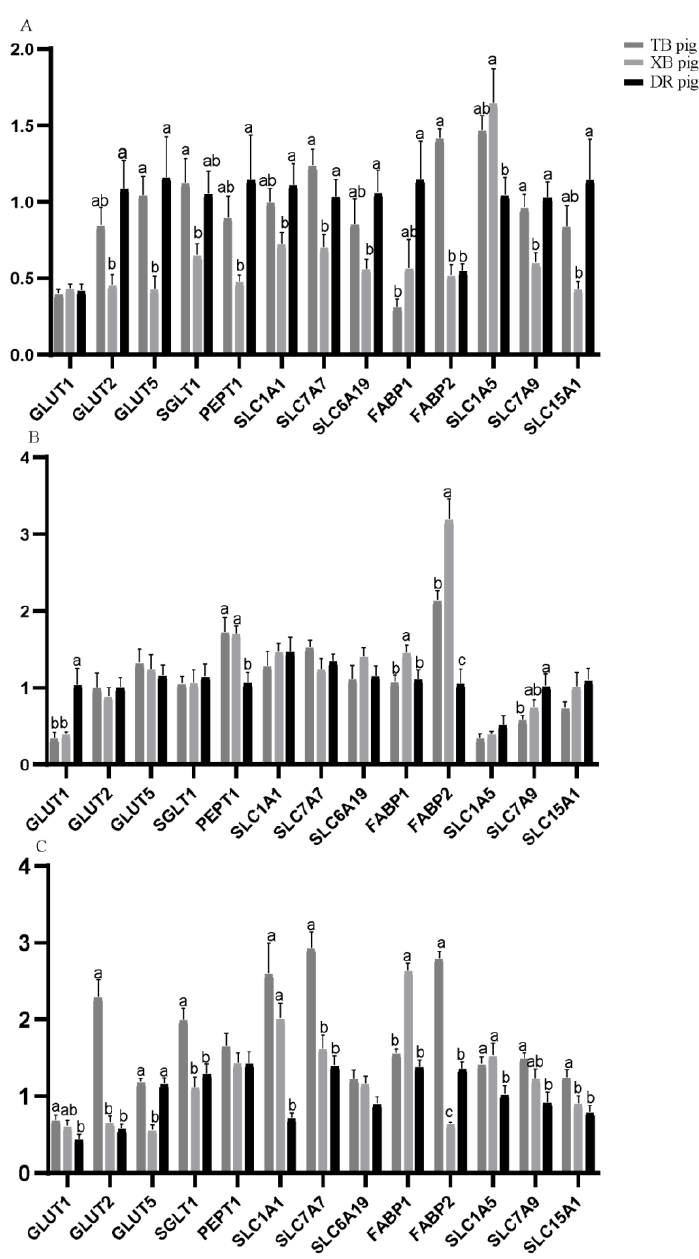
Figure 2. Nutrient transporter gene expression levels in the ileum of three pig breeds at different ages ( n = 8): ( A ) 80 days of age; ( B ) 125 days of age; ( C ) 185 days of age. a,b,c Different letters indicate a significant difference ( p < 0.05).